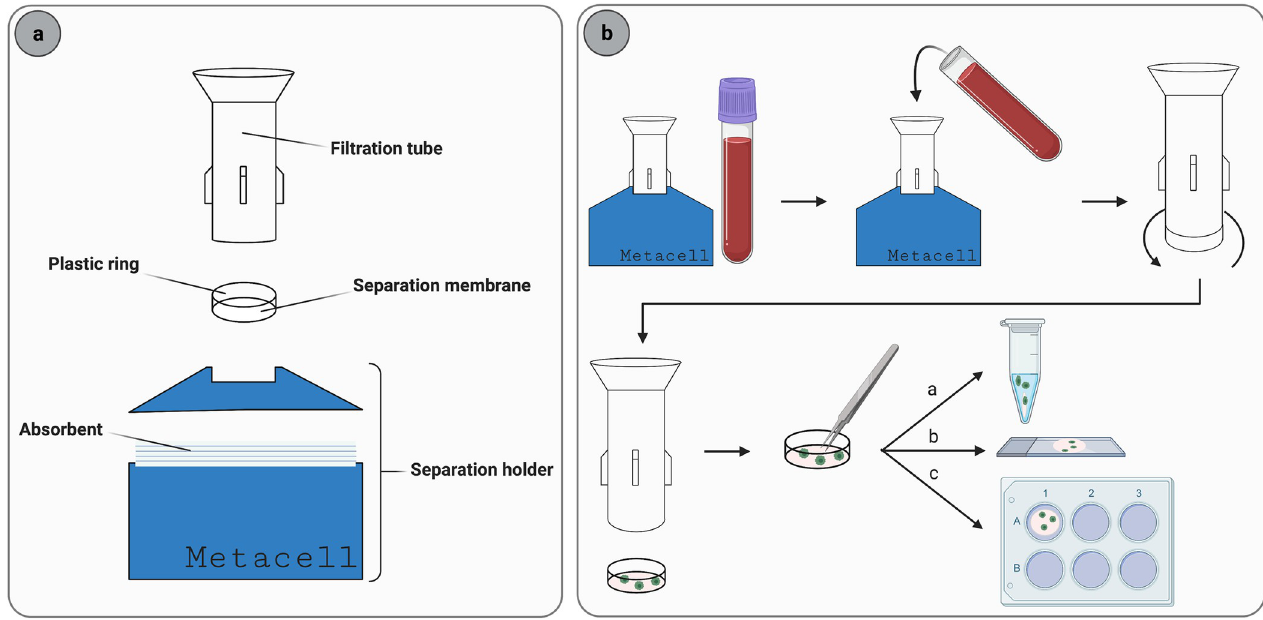
Fig 1. Overview of the Metacell 1 technology. A) Metacell 1 device in detail. B) Metacell 1 procedure. Blood is collected in the filtration tube with separation membrane. To start the filtration, the filtration tube is pushed down to make contact with the absorbent underneath. After filtration, the plastic ring with the separation membrane is unscrewed from the filtration unit. The separation membrane is then detached and used for characterization (a), cytomorphological evaluation (b), or culturing (c) followed by characterization or cytomorphological evaluation.